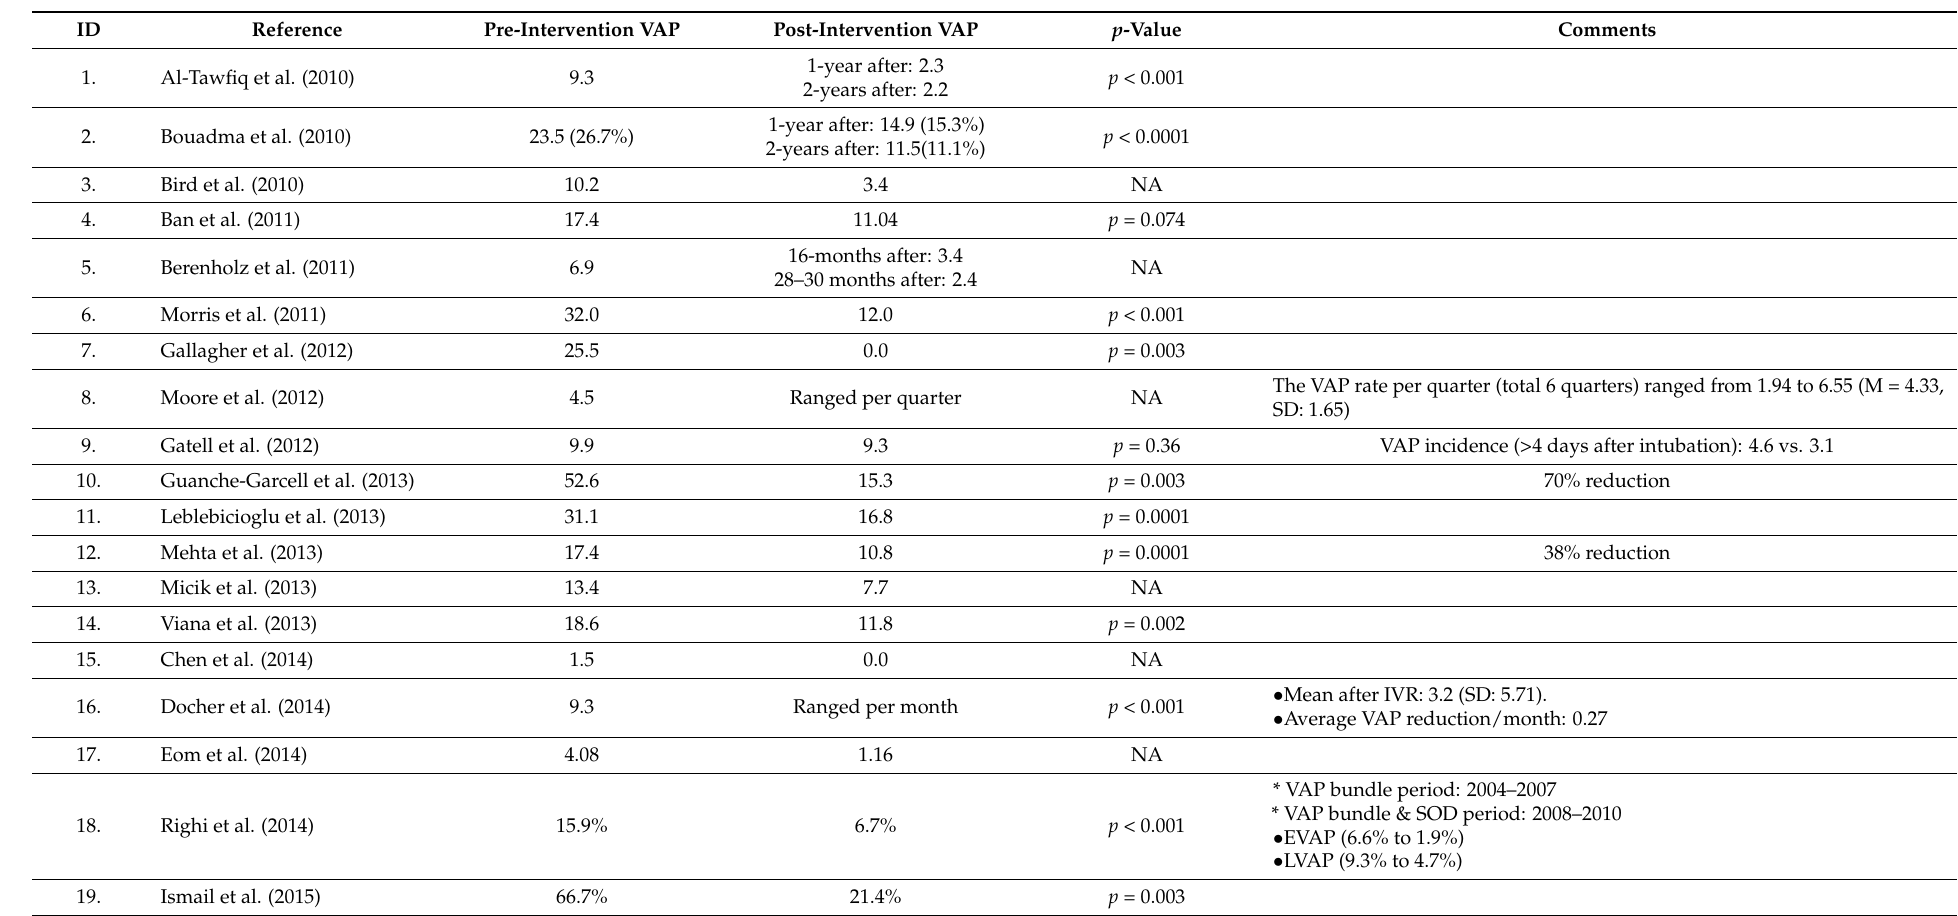
Table 3. Patient outcomes in each